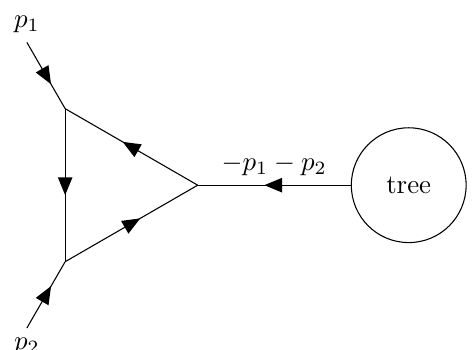
Figure 1 . This diagram is responsible for double poles in the holomorphic collinear limits of graviton amplitudes. Arrows indicate the flow of momenta and helicity through the